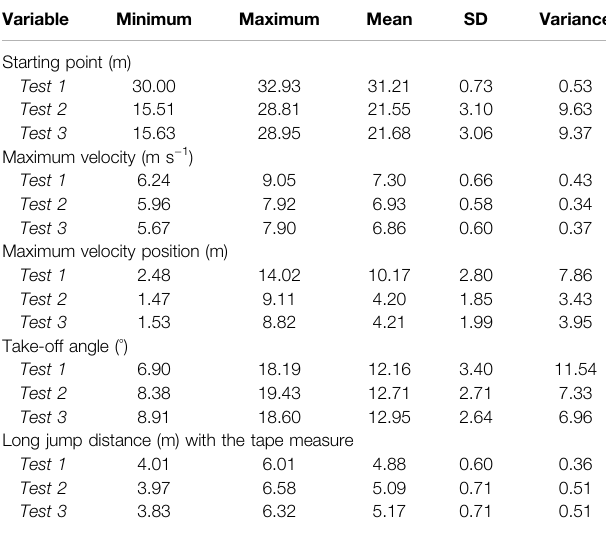
TABLE 2 | Descriptive statistics of the long jump tests ( N (cid:1) 22